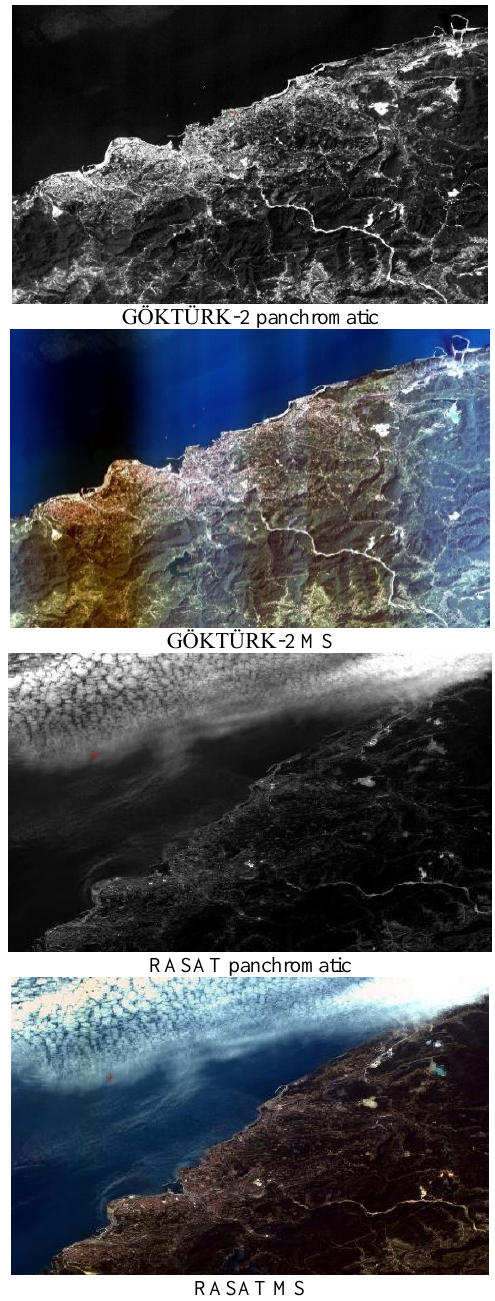
Figure 2. GÖKTÜRK-2 and RASAT images in Level 1. The pan-sharpening images were generated by SharpQ derived by the authors in Matlab environment. Figure 3 shows the pan- sharpened images generated. Results of GÖKTÜRK-2 reach more success since its sensor has more radiometric and geometric resolution than of RASAT. Correlation coefficients for RASAT image was 0.9678 and GÖKTÜRK-2 image was 0.9542, which both are close the optimal value (1) of this metric. This means the Figure 1. Zonguldak test site (Turkey). pan-sharpening of both images has a satisfactory success with respect to spatial metric. Not only the quantitative analysis, but also a visual comparison was carried out for the qualitative